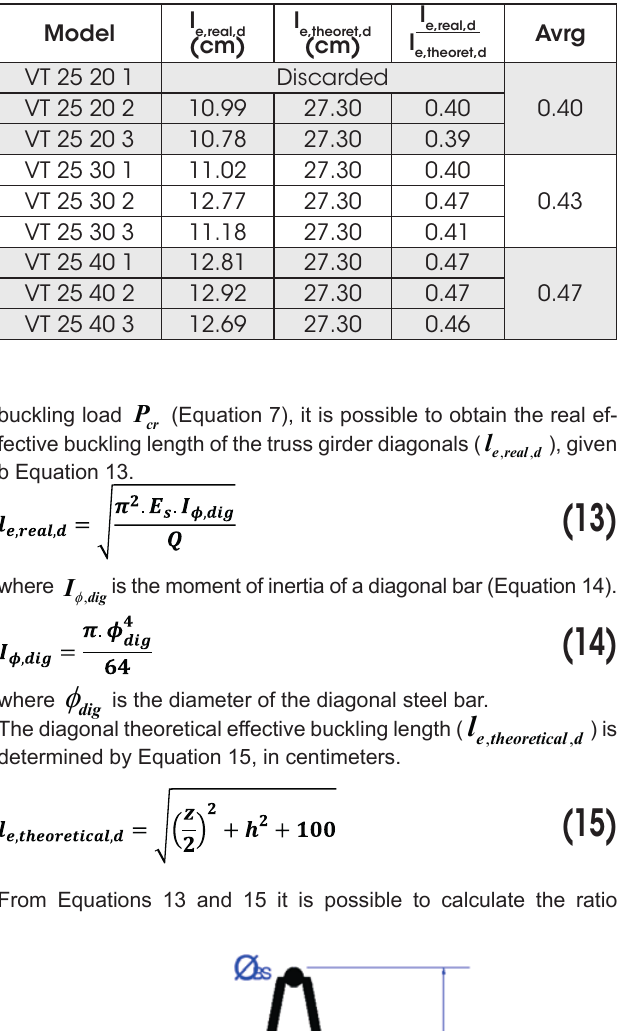
Values of l for the lattice joists which presented a failure mode due to buckling of the diagonal bars e,real